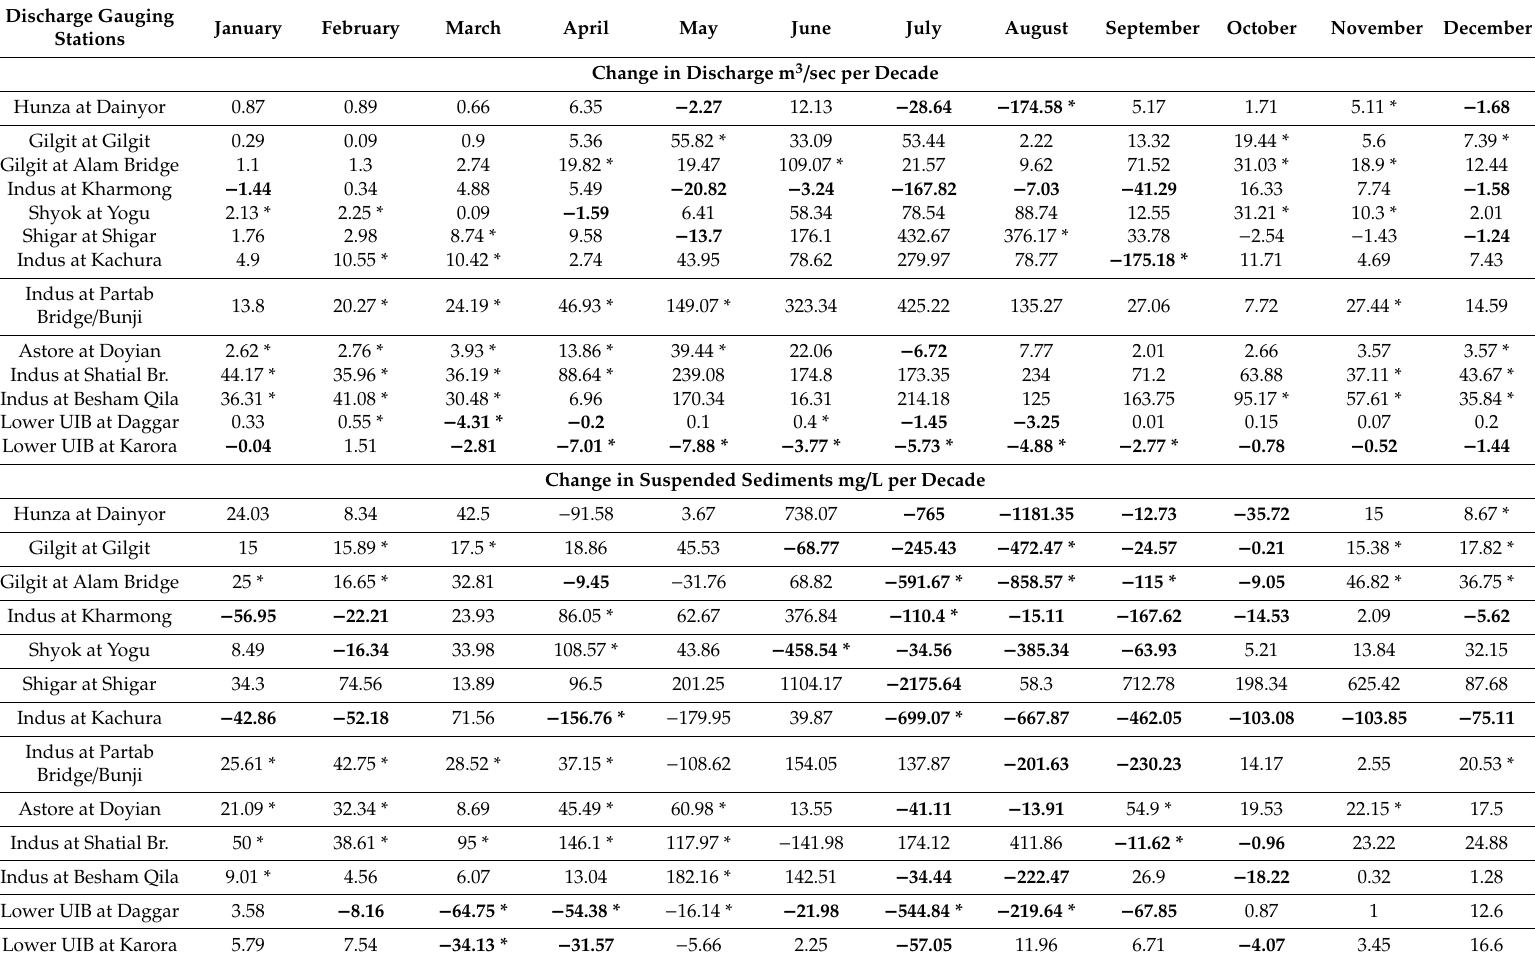
Table 6. Mann–Kendall trends for monthly time series data and Sen’s slope